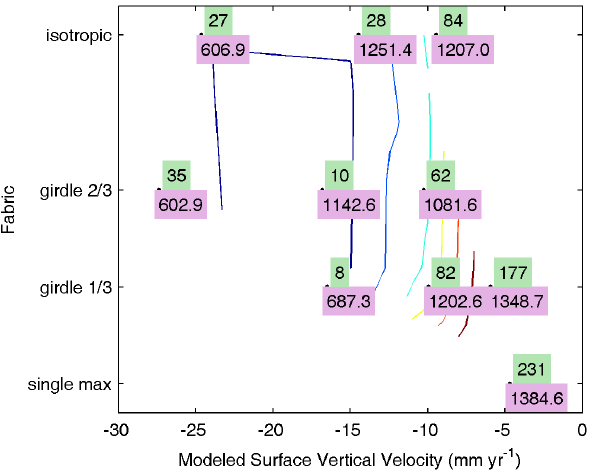
Figure 5. Relationship between vertical surface velocity w s and fabric shows that there is a minimum mismatch of age (contoured root mean square, in kyr; green boxed values) between the observed radar isochrones and those modelled for various fabrics. Numbers in magenta boxes are the basal ages for those simulations. The mis- match in ages is least for 20> w s >15mmyr − 1 , whereas simplistic expectations assuming fixed geometry and accumulation rate vari- ability over a glacial cycle would suggest a long-term steady-state surface mass balance and w s of about 14mmyr − 1